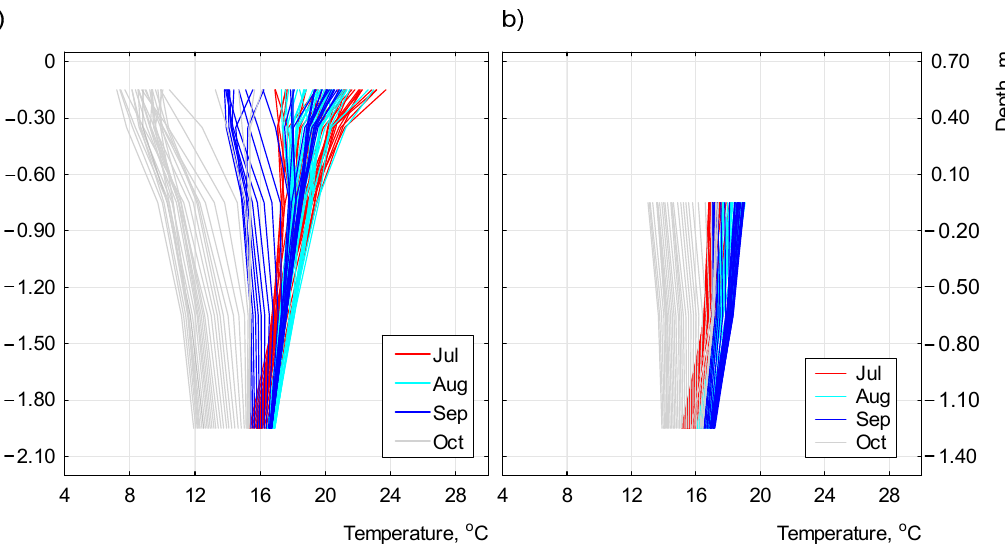
Figure 5. Hourly ground temperatures at various depths; 1 May–31 October: ( a ) Profile I; ( b ) Profile I.